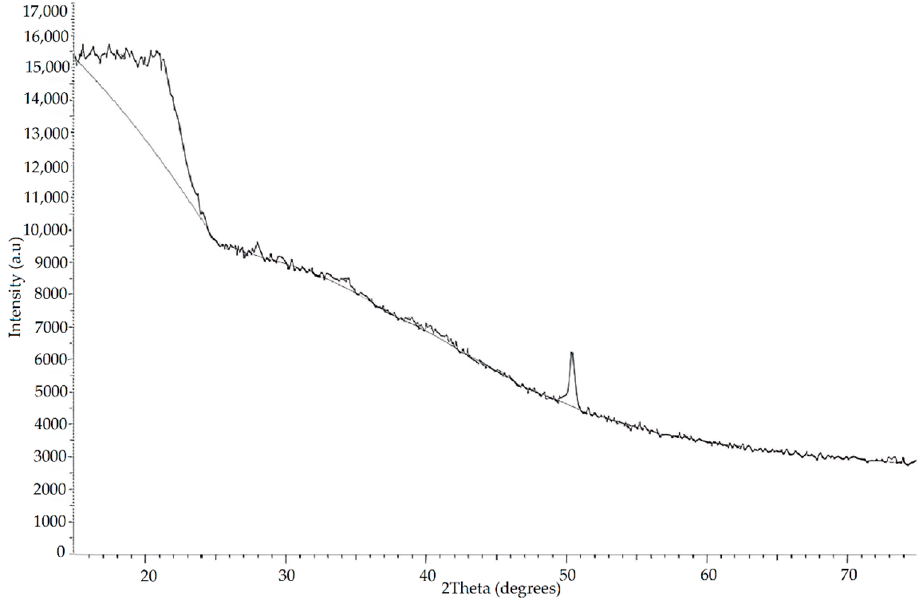
Figure 6. X-ray analysis of artichoke leave powder.